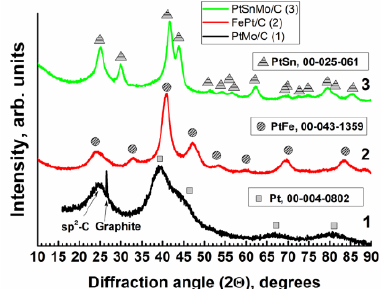
Figure 1. XRD patterns of the PtMo/C (1), PtFe/C (2) and PtMoSn/C (3) catalysts. Symbols mark positions of main reflections of principal phases (Pt, PtFe, PtSn) with corresponding numbers of International Center for Diffraction Data (ICDD) cards. Small shifts of the observed peaks from the ideal positions are due to solid solution effects.